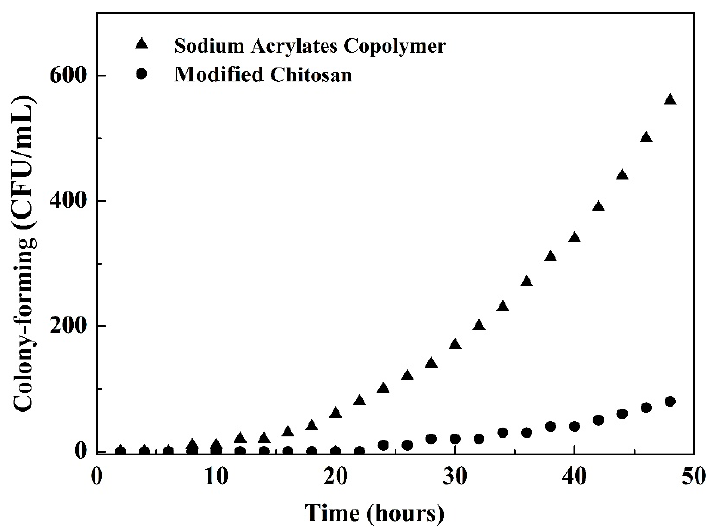
Figure 7. Comparison of numbers of bacteria for different emulsifiers.